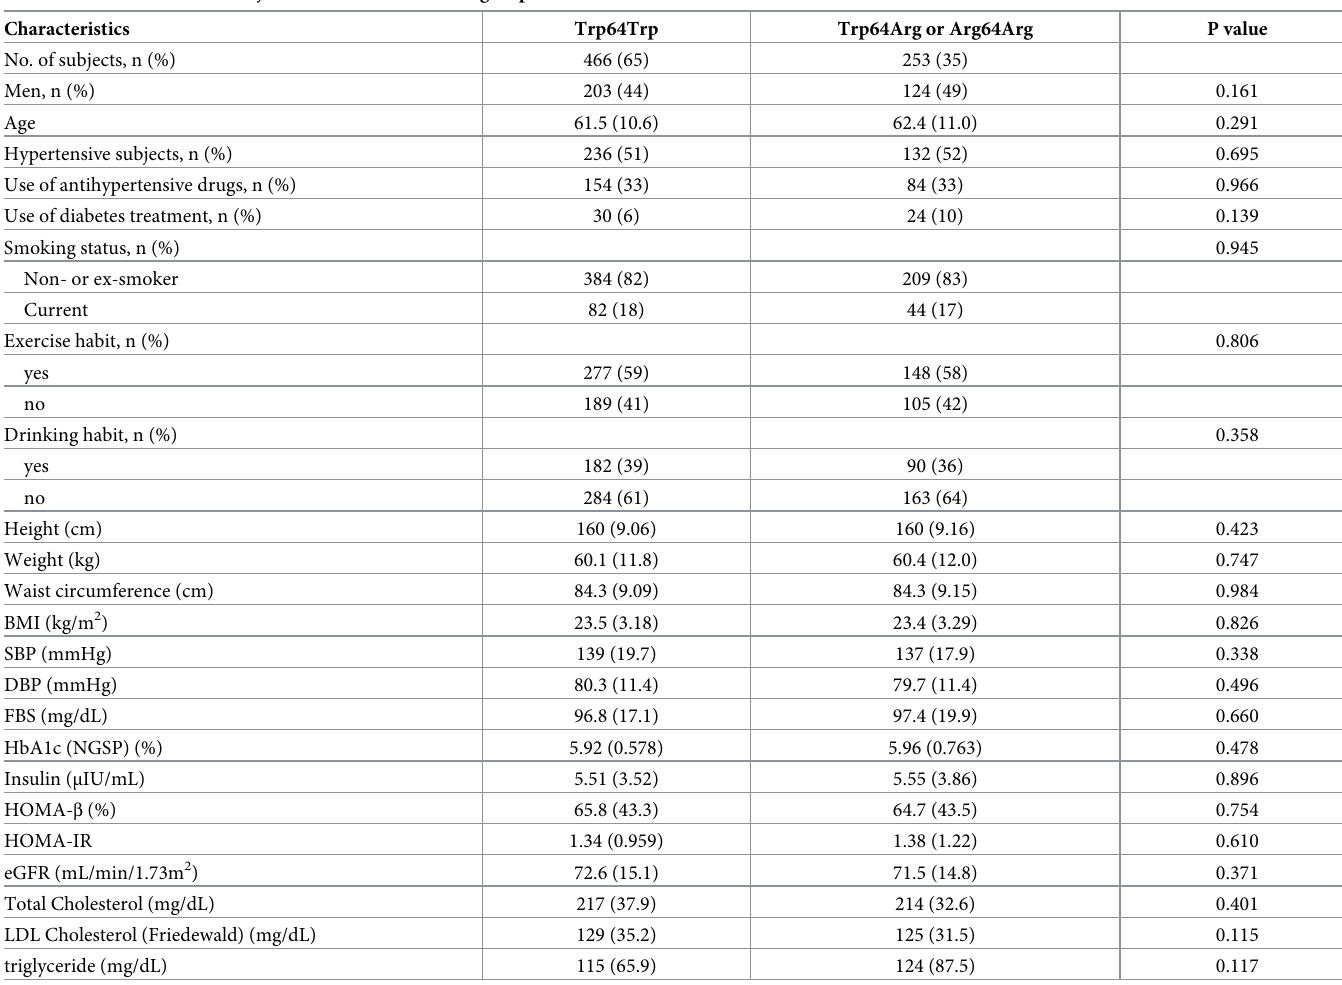
Table 2. Characteristics of subjects in two different allele